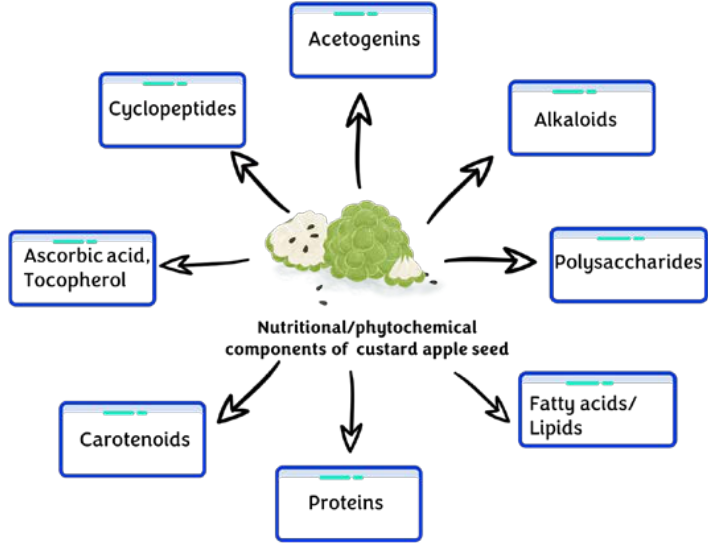
Figure 2. Major nutritional and phytochemical components of Annona squamosa seed.